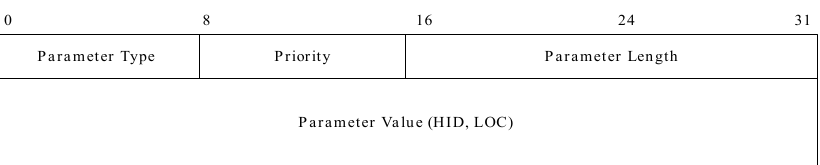
Figure 13. Parameter type ‐ length ‐ value (TLV) format.